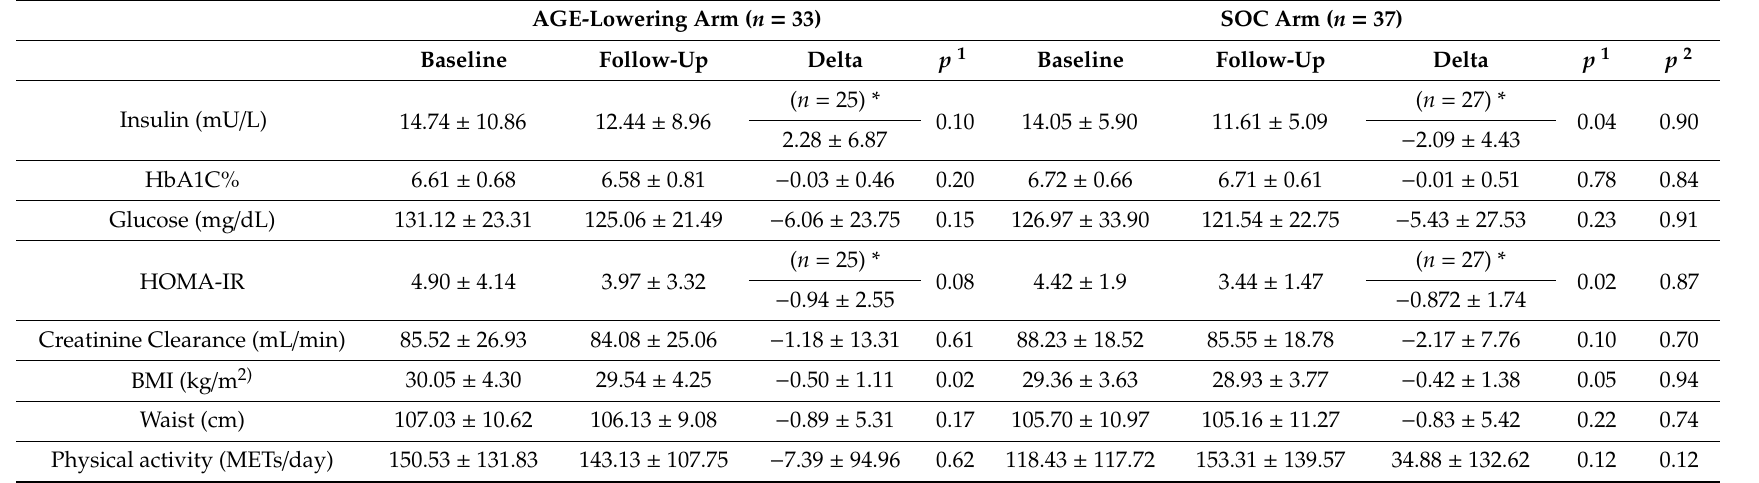
Table 4. Mean change in metabolic markers after 6 months